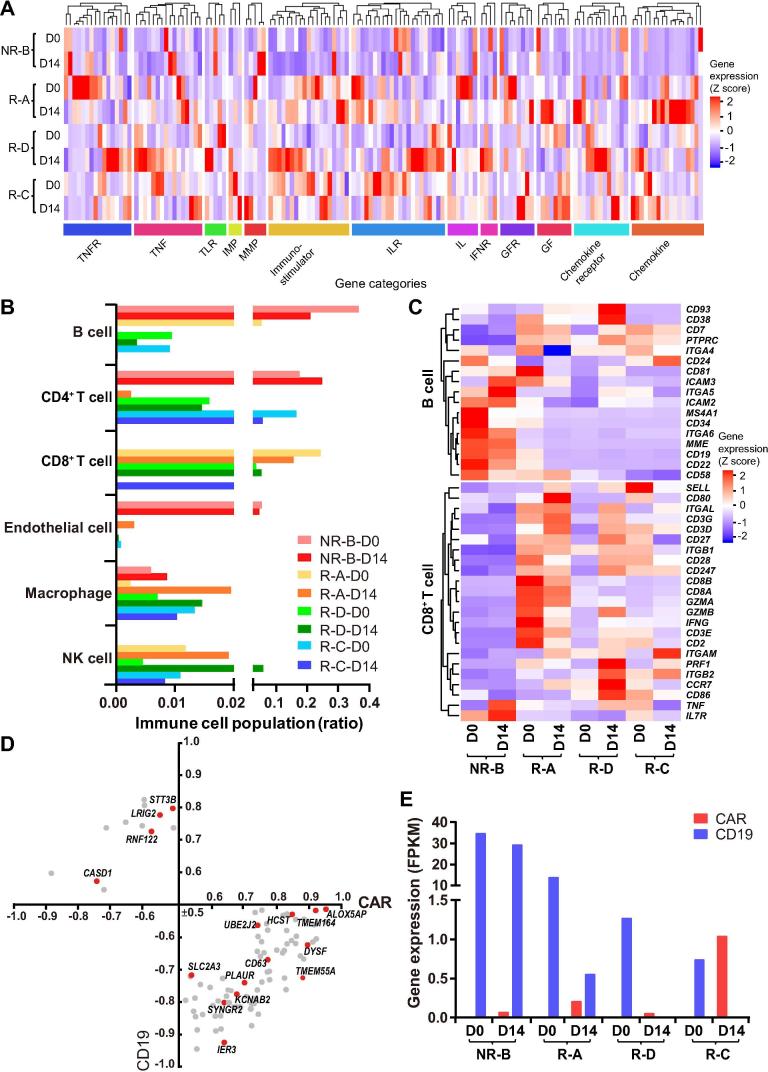
Expression of CAR, CD19, and genes associated with immune functions in BM samples before and after CAR-T infusionA. Heatmap of immune microenvironment and immunostimulator genes. The blue to red coloring in the legend indicates the gene expression level (Z score scaled) from low to high. Hierarchical clustering analysis was carried out by calculating the Euclidean distances. The categories of the microenvironment and immunostimulator genes determined by gene functions are indicated below the heatmap. B. The distribution of immune cell populations within the BM of patients among patients on D0 and D14. C. Heatmap of marker genes of B cells (including pro-B and pre-pro-B cells) and key genes related to the cytotoxic function of CD8+ T cell. D. Pearson's correlation of membrane protein genes for CD19 and CAR expression (P < 0.05, |correlation| ≥0.5). The red dot indicates the gene that was found to be involved in leukemia. E. The expression levels of the CAR and CD19 genes in the BM of patients on D0 and D14. All the data shown in this figure were based on RNA-seq analyses. TNF, tumor necrosis factor; TNFR, TNF receptor; TLR, toll like receptor; IMP, tissue inhibitor of metalloproteinase; MMP, matrix metallopeptidase; IL, interleukin; ILR, IL receptor; IFNR, interferon alpha and beta receptor; GF, growth factor; GFR, GF receptor; NK, natural killer.